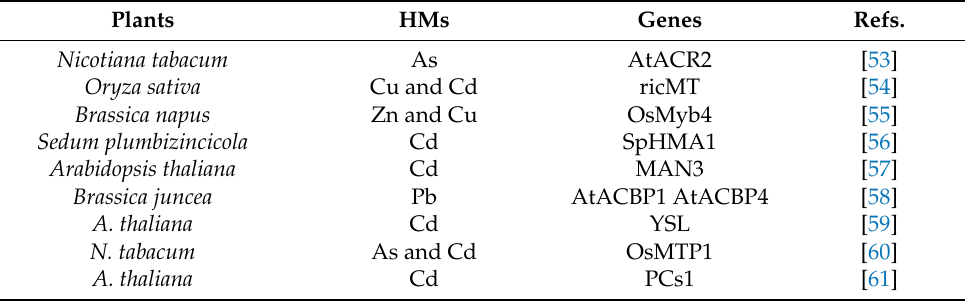
Table 2. Some important transgenic plants applied for the removal of HMs. Plants HMs